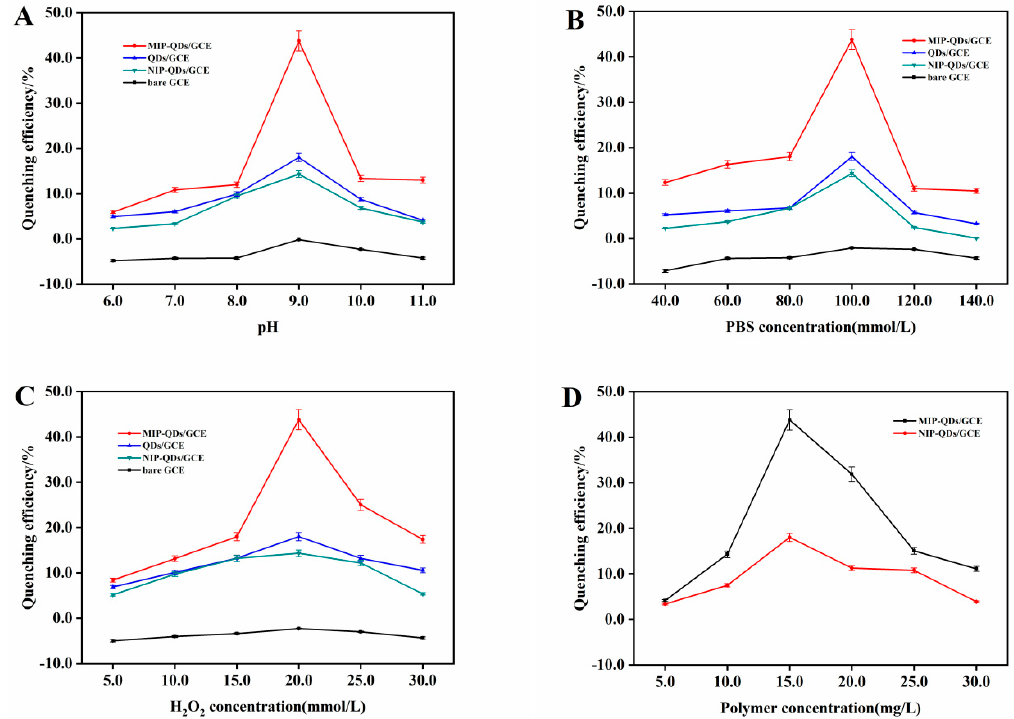
Figure 5. E ff ects of experimental conditions on the quenching e ffi ciency of MIP-QDs / GCE, NIP- Figure 5. Effects of experimental conditions on the quenching efficiency of MIP-QDs/GCE, NIP- QDs / GCE, bare GCE and QDs / GCE: ( A ) The PBS pH in the ECL cell; ( B ) The concentration of PBS; ( C ) QDs/GCE, bare GCE and QDs/GCE: ( A ) The PBS pH in the ECL cell; ( B ) The concentration of PBS; The concentration of H 2 O 2 ; ( D ) The concentration of ( C ) The concentration of H 2 O 2 ; ( D ) The concentration of polymers.